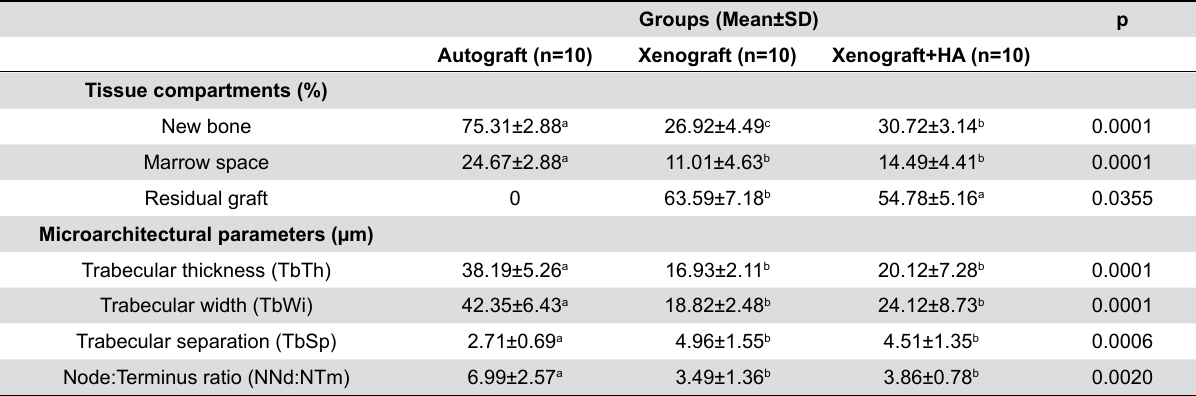
Table 1- Histomorphometric comparisons of the study groups. Concerning “tissue compartments”; percentages of new bone, marrow space, and residual graft materials are shown. Concerning “microarchitectural parameters”; trabecular thickness, trabecular width, trabecular separation, and node:terminus ratio values of the newly formed bone are shown. Results are presented as means ± standard deviations (SD)